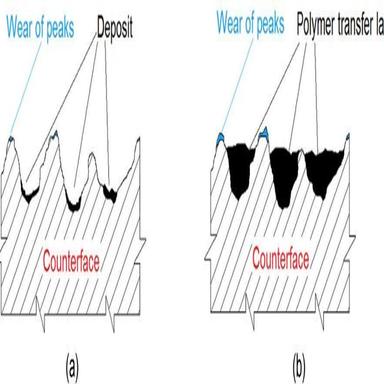
Transfer layer formation on steel counterface in sliding wear: high asperities of the steel (a), decreased surface roughness and asperities (b).